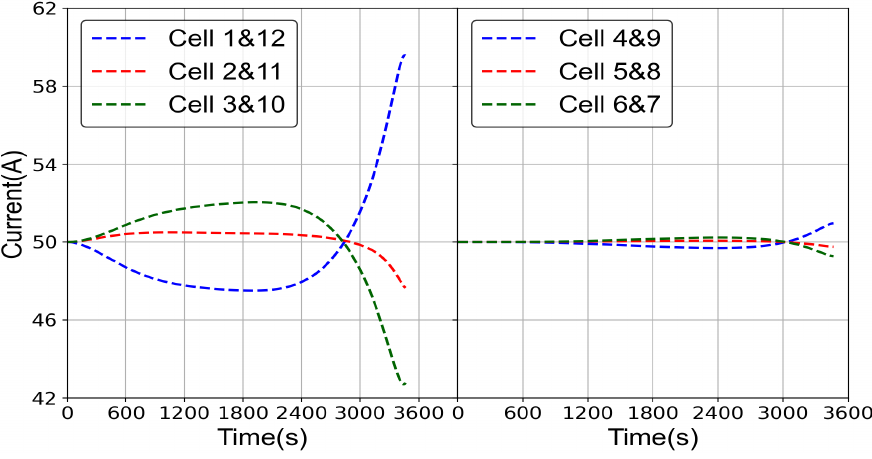
Figure 12. Current distribution of the pack under the inhomogeneous cooling case 13.